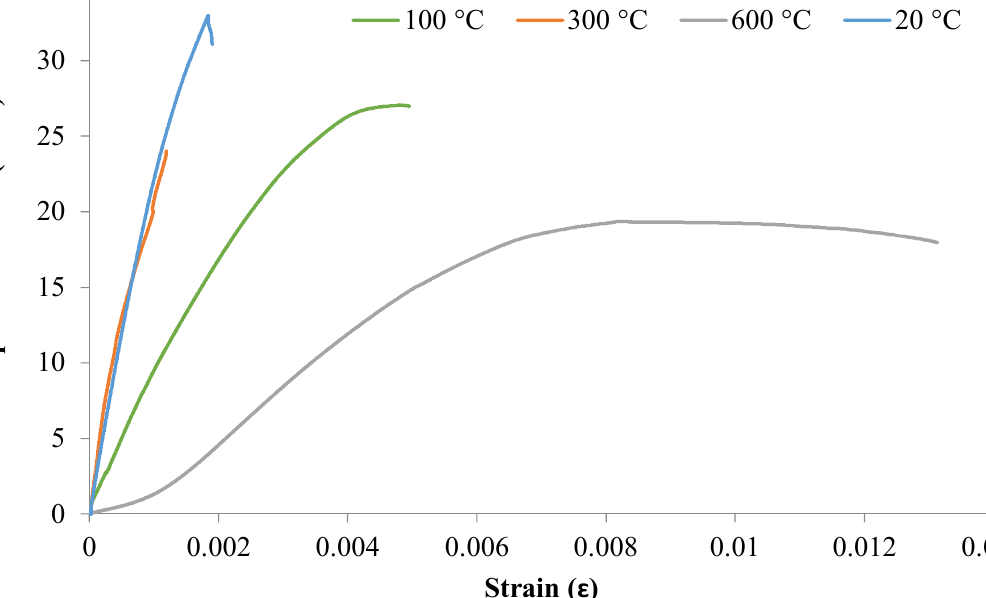
Figure 11. Compressive stress–strain curves for M4 after 28 days at high temperatures. Figures 9–11 show that the M2, M3, and M4 mixes exposed to high temperature lost their structural integrity when decreasing their compressive strengths and stiffness, which led to easy deformation. Generally, because of the decrease in compressive strength and the increase in the strain of the concrete, the slope of the stress–strain curve decreased with increasing temperature. The